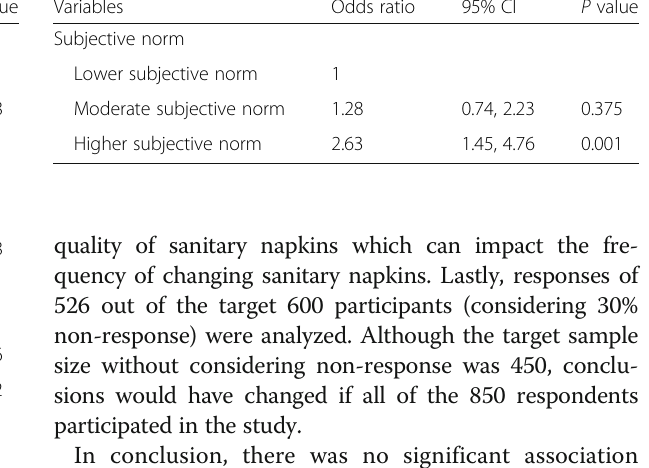
Table 3 Multivariate analysis with frequency of changing